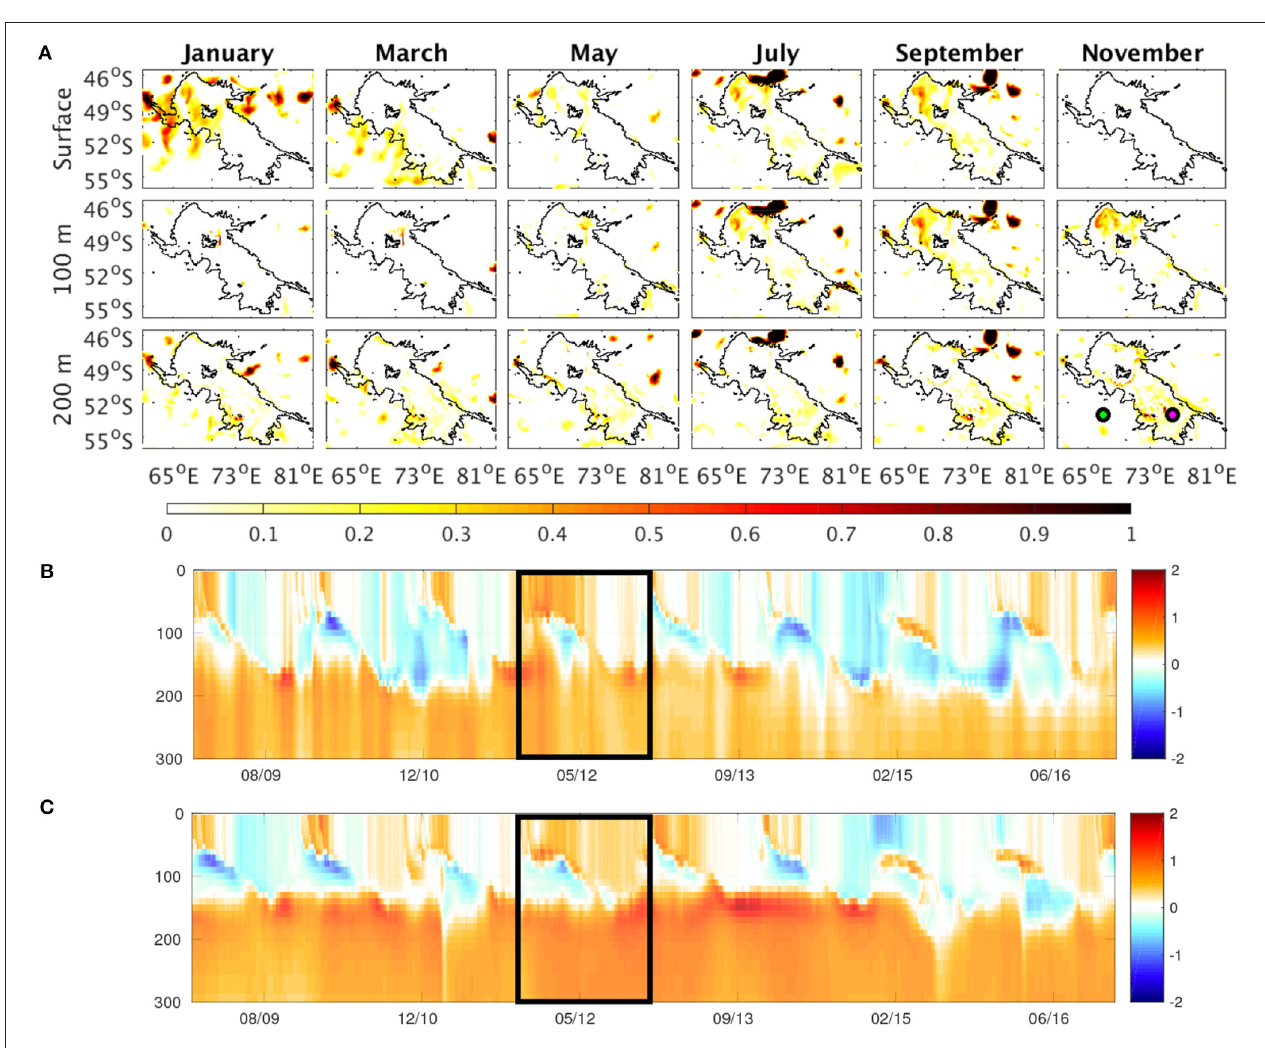
FIGURE 5 | (A) Monthly average of extreme temperatures (i.e., above the 90th percentile relative to climatology) for alternated months of 2012 at the surface (top), 100 m (middle), and 200 m (bottom) depths in OFAM; (B) Temperature anomaly, relative to climatology, at the western green dot in the last panel of (A) , from surface to 250 m depths; (C) as in (B) , but for the eastern pink dot in the last panel of (A) ; the black box indicates the year